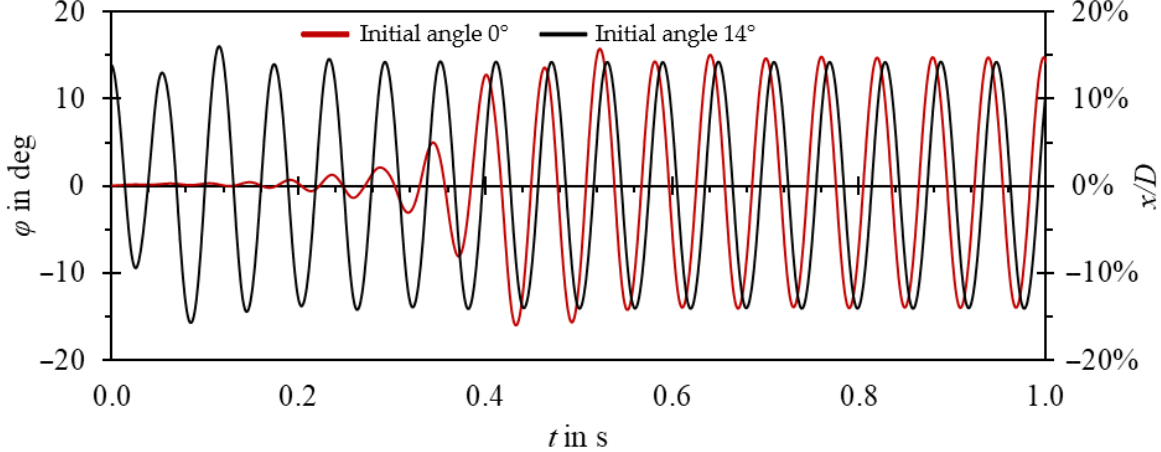
13 of 21 ( c ) Figure 12. Two-dimensional mesh for the overset method: ( a ) background mesh; ( b ) component mesh, which moves as a rigid body with the oscillator; ( c ) superimposed grids, an overlapping in- terface between grids is visible. The moment acting on the oscillator was the monitored value throughout the itera- tive calculation process. Iterative calculations were run until iterative convergence of mo- ment was reached, which in the transient case usually took place after no more than 30 iterations per time step.